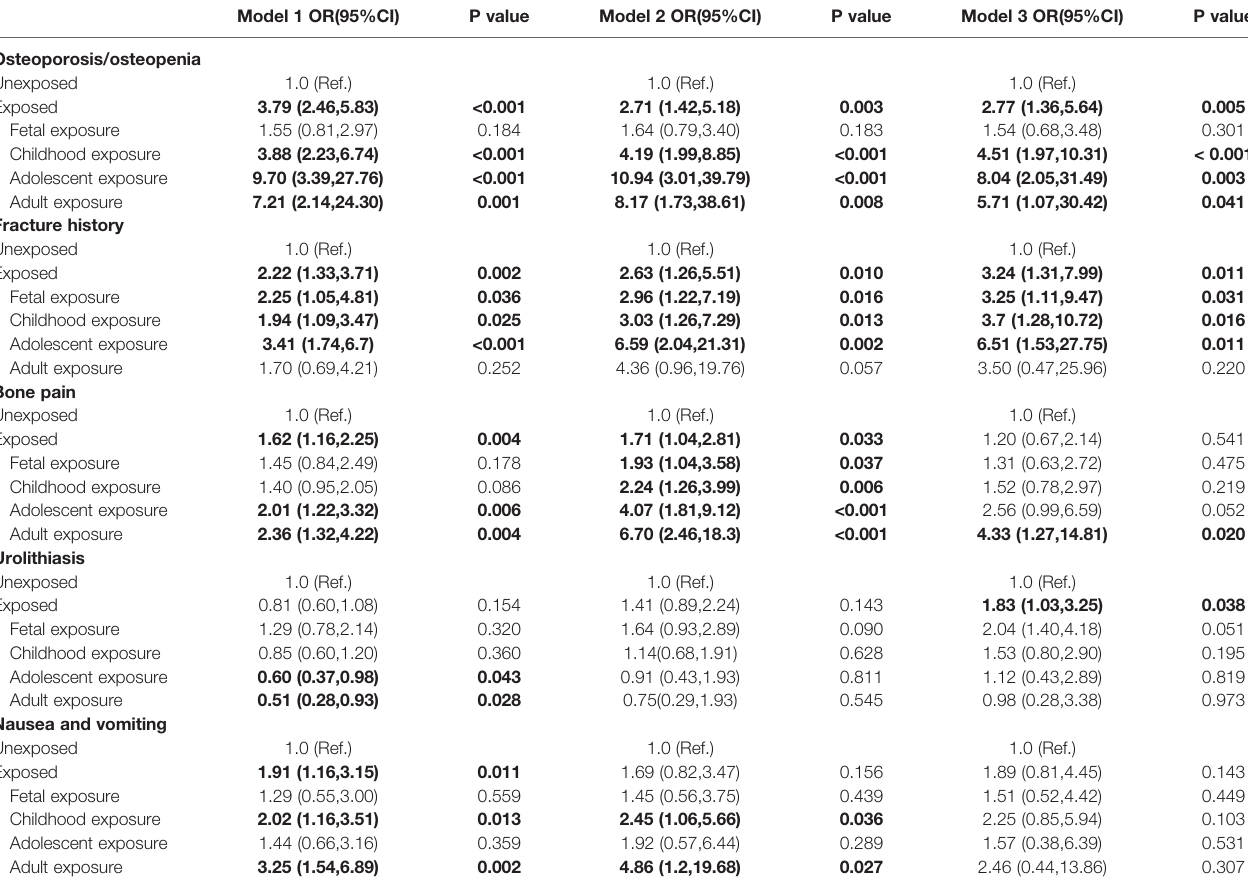
Model 1: unadjusted. Model 2: adjusted for age, gender. Model 3: adjusted for age, gender, BMI, disease duration, eGFR. Bold values represent results with statistical signi fi